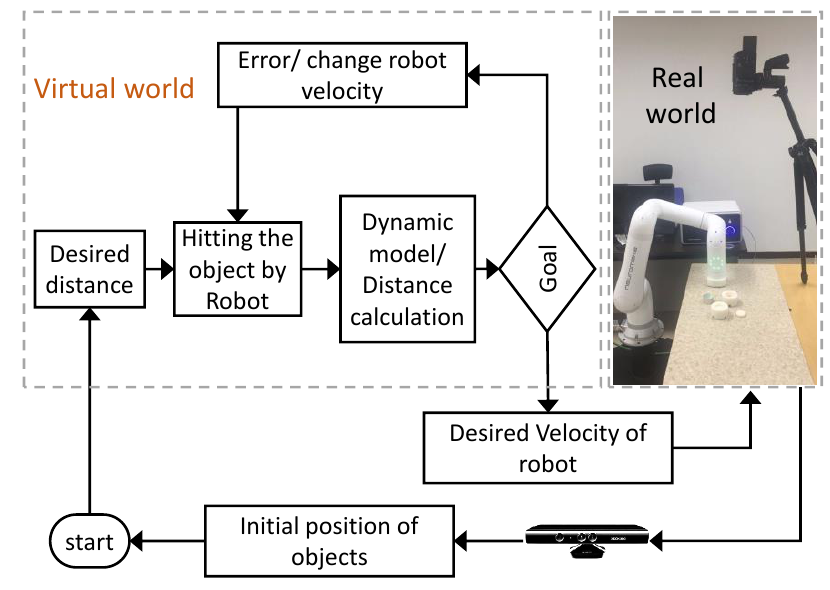
Figure 10. Impulse geometry: ( a ) normalized impulse ellipsoid for the Indy 7 robotics arm; ( b ) impulse ellipsoid for the four configurations; ( c ) maximum and minimum impulse direction.